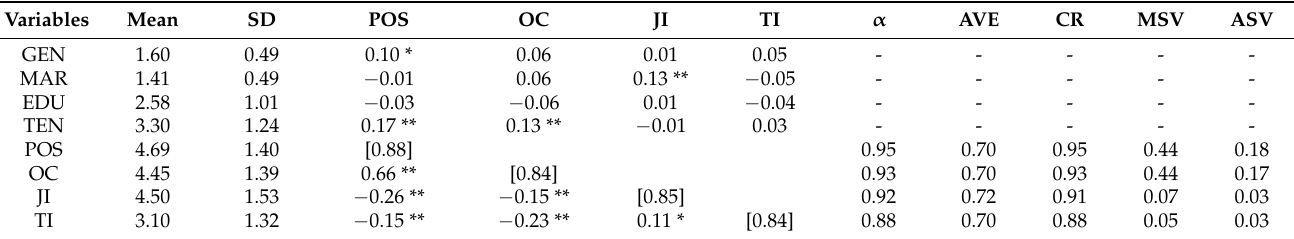
Table 4. Correlations, convergent, and discriminant